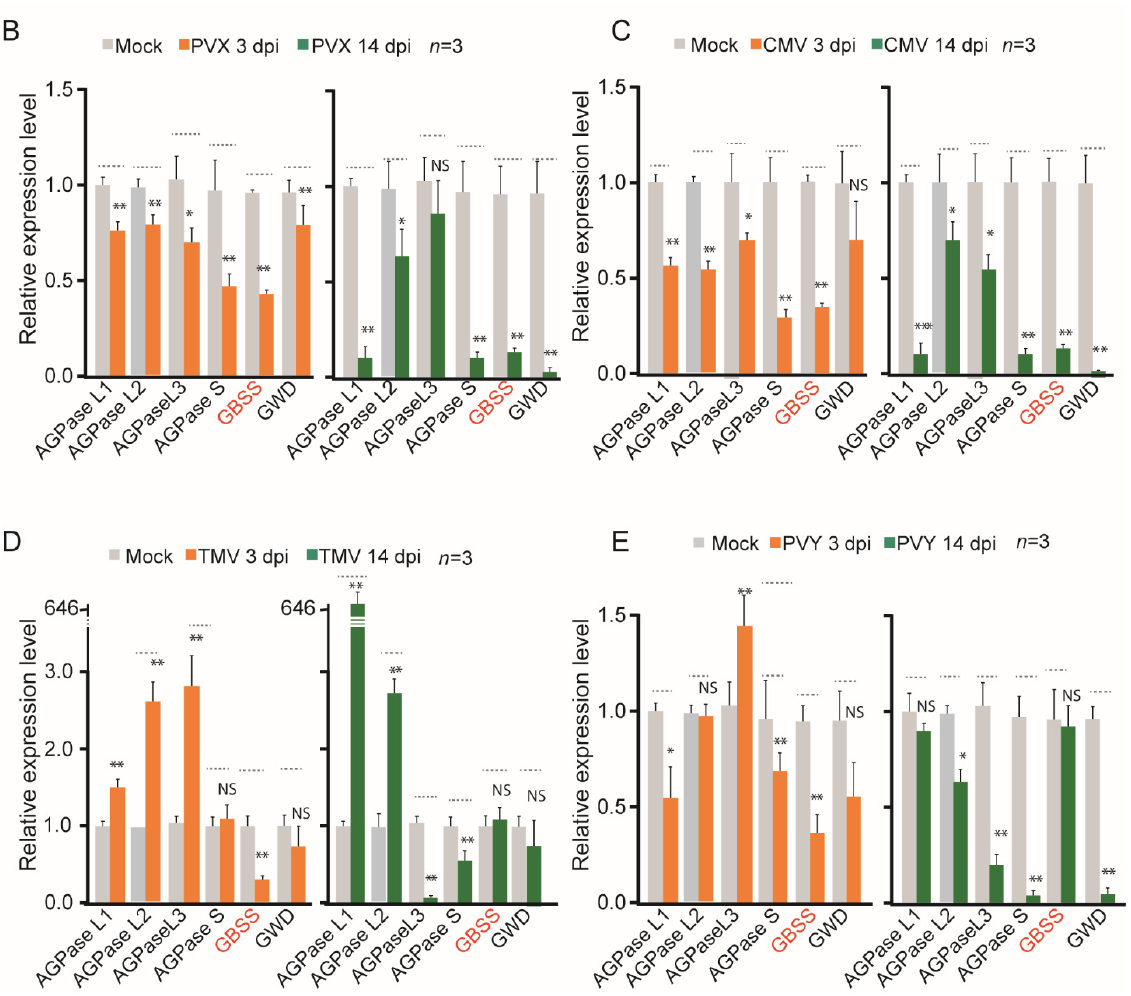
Figure 4. Effect of virus infection on the transcriptional expression of genes involved in starch metabolism. ( A ) A schematic diagram of the starch metabolism pathways in the chloroplast. ( B–E ) The relative transcriptional expression of genes encoding enzymes involved in starch metabolism in N. benthamiana plants infected with PVX, CMV, TMV or PVY. Data are presented as mean ± SD. The mock sample data value was set to 1.0. “*”, and “**”, indicating a significant difference at p < 0.05, and 0.01, respectively. “NS” indicates no significant difference (Student’s t -test).